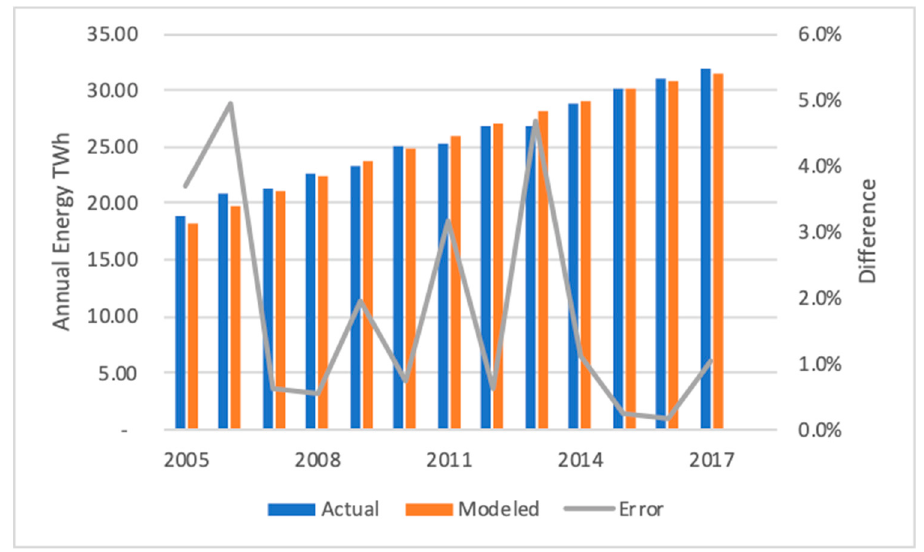
Figure 7. Comparison of the actual and modeled annual residential sector energy use from 2005 to 2017.